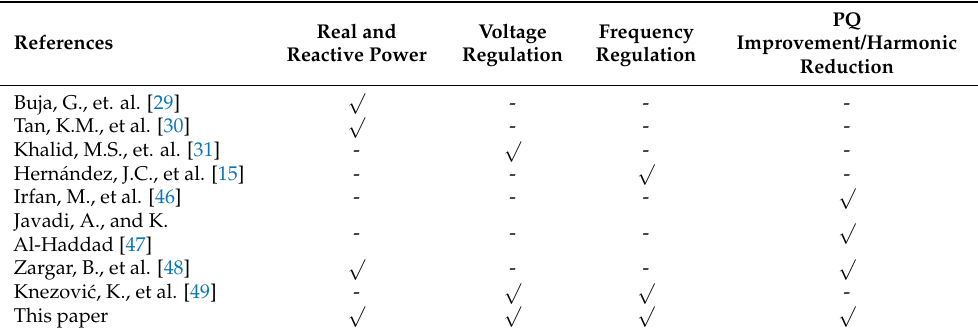
Table 2. Service benefit comparison of EVGI systems.